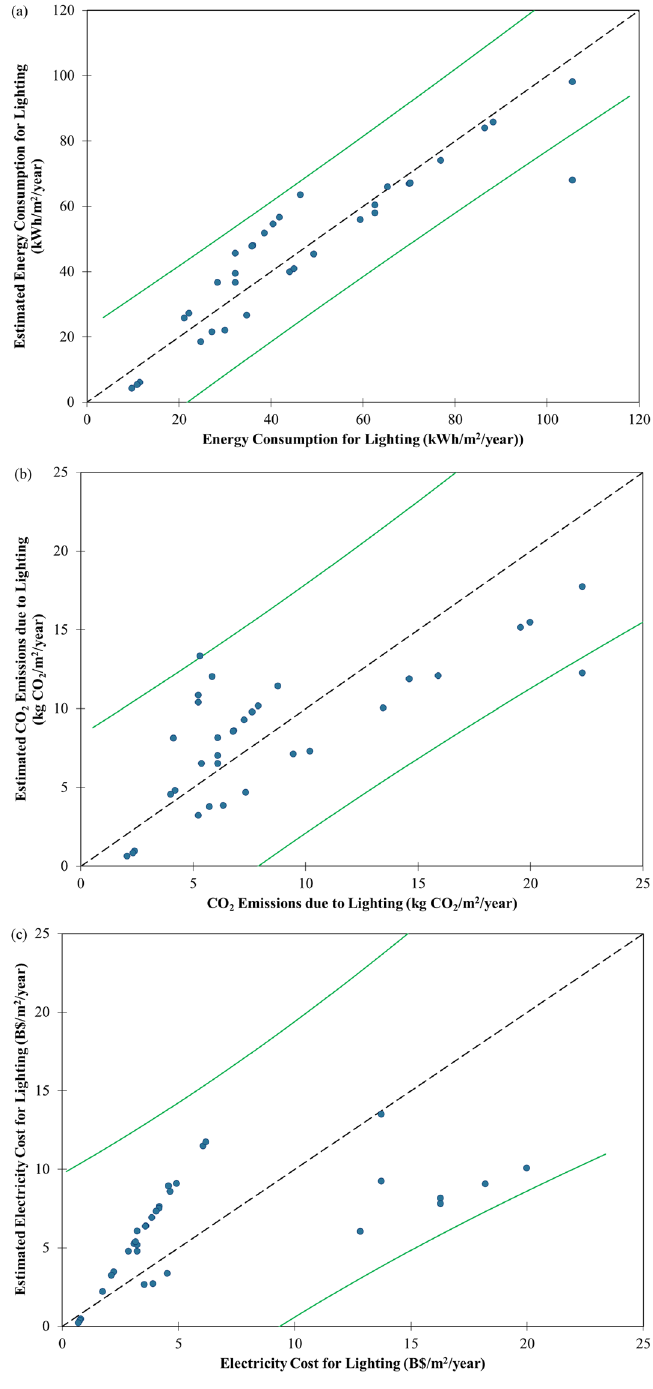
Figure 3. Scatter plots of calculated and estimated (a) energy consumption, (b) CO 2 emissions and (c) electricity costs for lighting by linear regression model for commercial buildings in Southeast Asia with 95% confidence interval (represented by the green